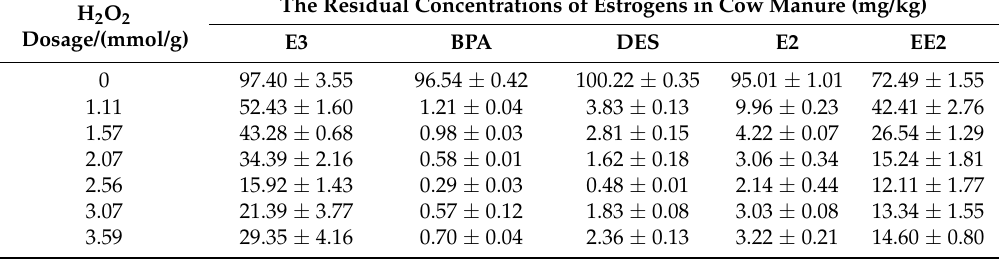
Table 2. Effect of H 2 O 2 dosage on the residual concentrations of estrogens in cow manure by the Fenton oxidation process. Note: the Fe(II) to H 2 O 2 molar ratio was 0.10 M/M; the solid to water mass ratio was 2 g/mL; the initial pH value was 3.0; the reaction time was 24 h. H 2 O 2